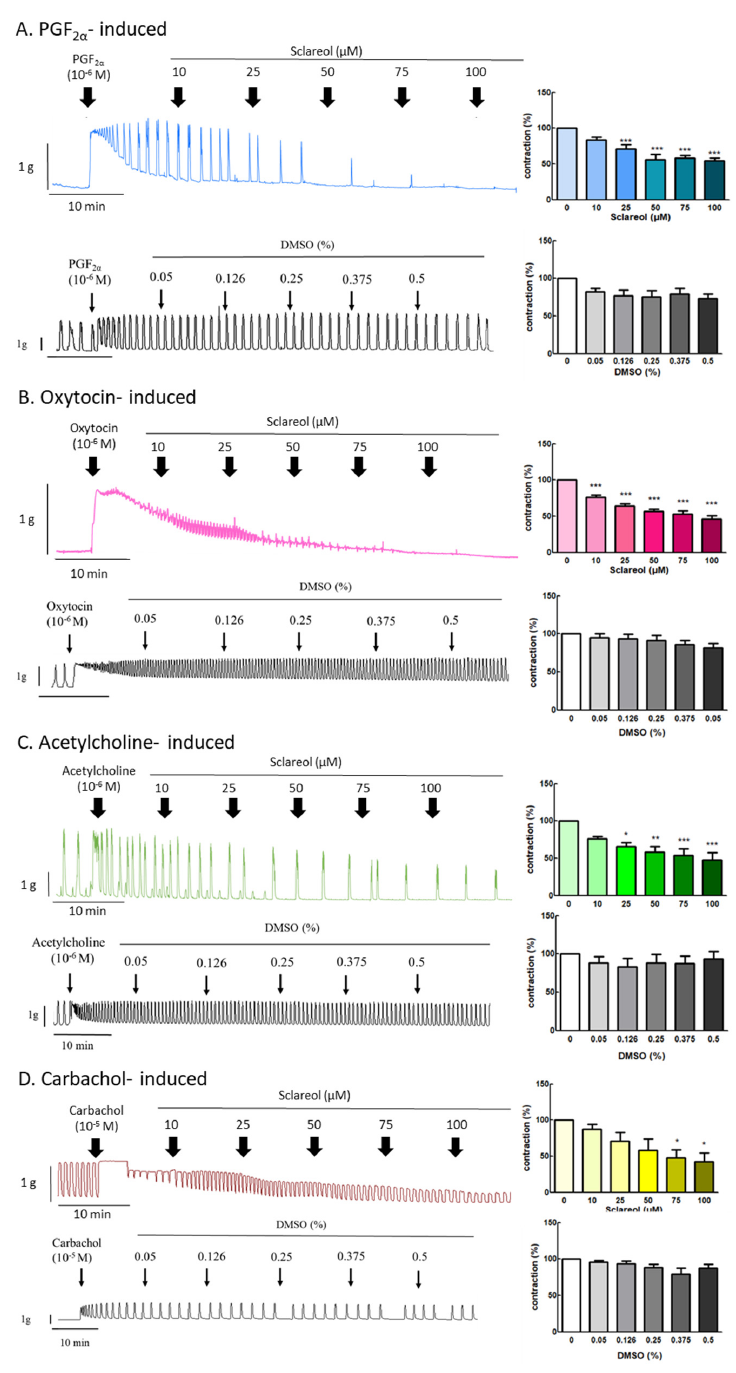
Figure 3. E ff ect of sclareol on drug-induced uterine contraction. Representative recordings of rat uterine tissues were induced with ( A ) 10 − 6 M PGF2 α , ( B ) 10 − 6 M oxytocin, ( C ) 10 − 5 M carbachol, and ( D ) 10 − 6 M acetylcholine Ach, with exposure of rat uterine smooth muscles to sclareol (10, 25, 50, 75, and 100 µ M). Dose-dependent e ff ects of sclareol on the mean peak amplitude. Each column represents the mean ± SEM; n = 4–8. * p < 0.05, ** p < 0.01 and *** p < 0.001 compared to 0 (drug-induced